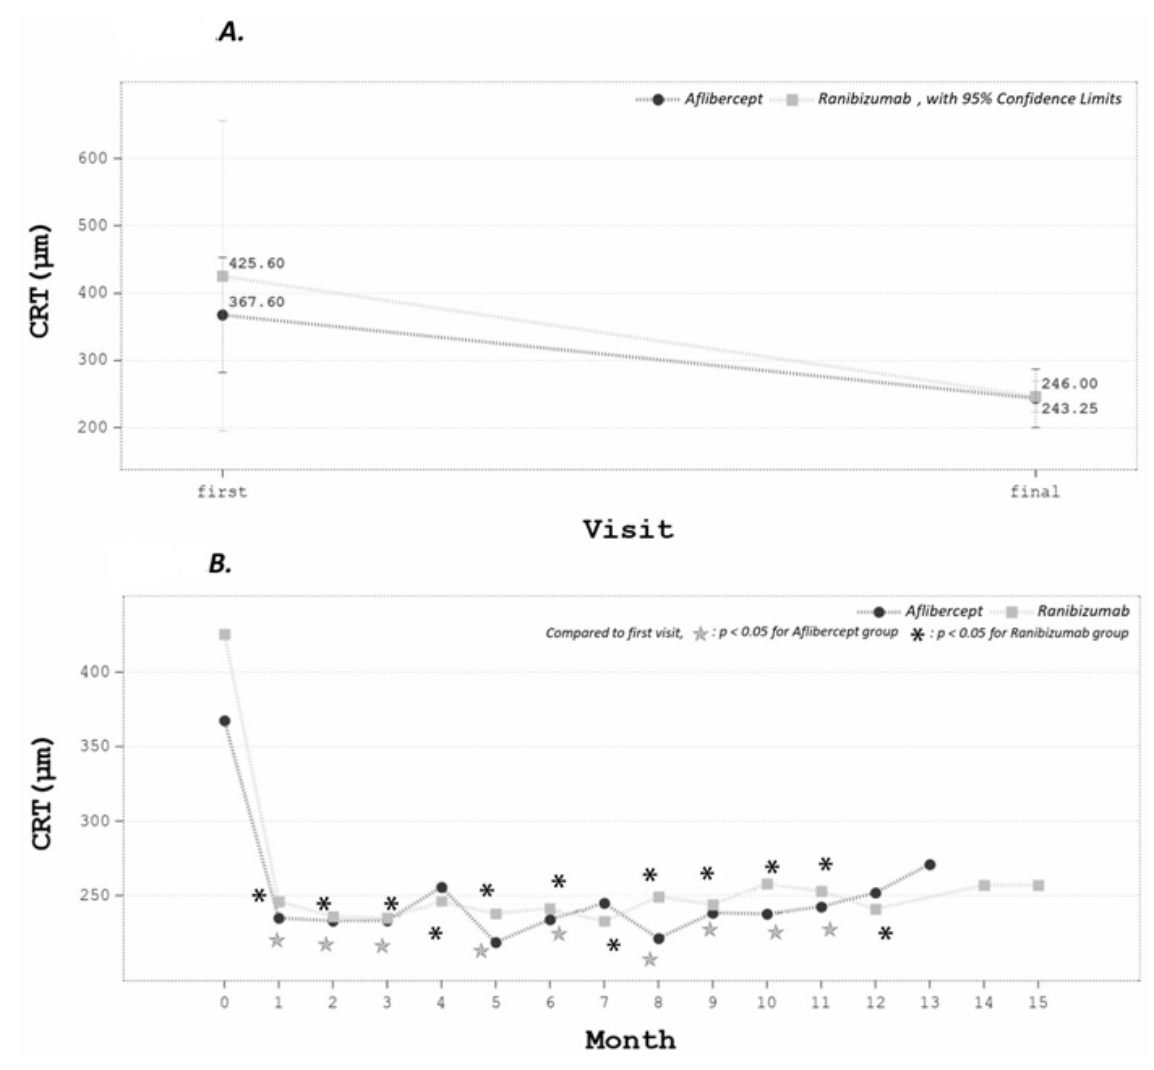
Figure 1. ( A ) The CRT improved significantly. ( B ) From serial follow-up data, CRT significantly improved since the first follow-up month.